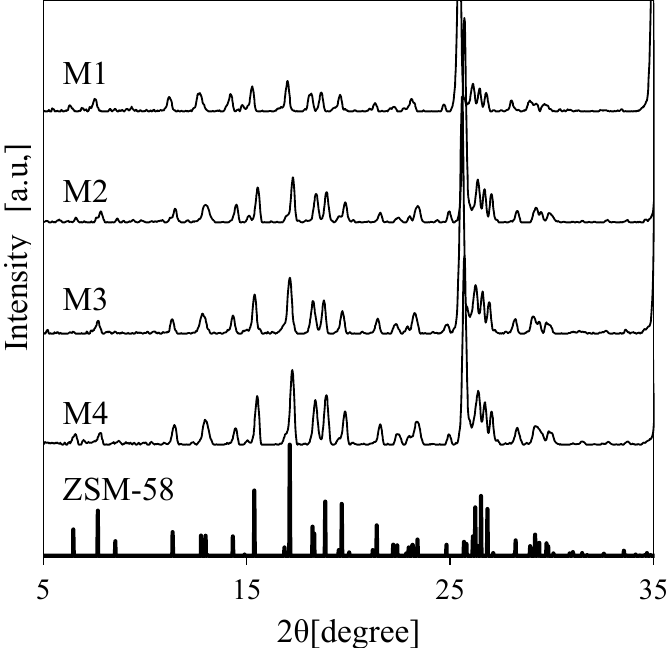
Figure 6. XRD profile of ZSM-58 zeolite membranes using various synthesis periods.